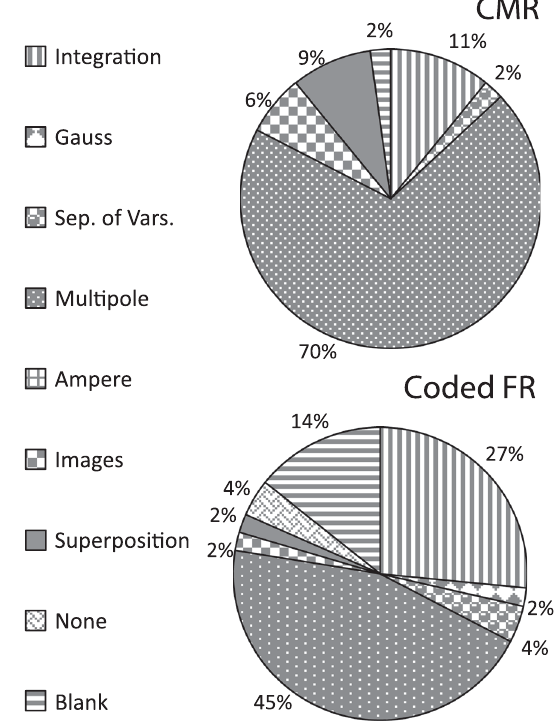
FIG. 6. Percent of students who selected each method on Q3 (see Fig. 2) for each version of the CUE. The top chart represents student selections from the CMR version ( N ¼ 45 ), while the bottom chart represents coded method selections from the FR version ( N ¼ 49 ). The difference between the two distributions is statistically significant (Fisher ’ s exact test, p < 0 . 05